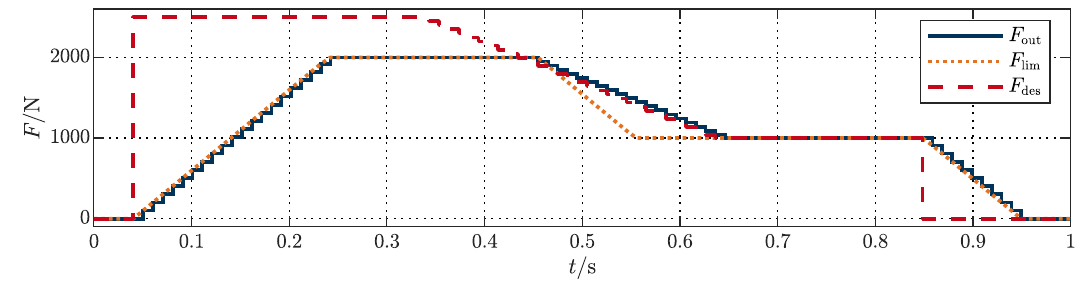
Figure 4. Example of input constraints